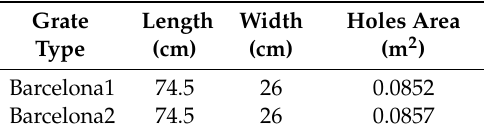
Figure 5. Grates tested in the experimental campaign; ( a ) Grate type “Barcelona1”; ( b ) Grate type “Barcelona2”. Table 2. Geometry of the grate inlets tested.